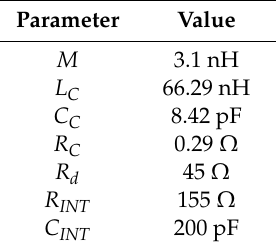
Figure 15. Double-pulse test (DPT) experiment for current measurement. Table 3. Parameters of the pick-up coil current sensor.